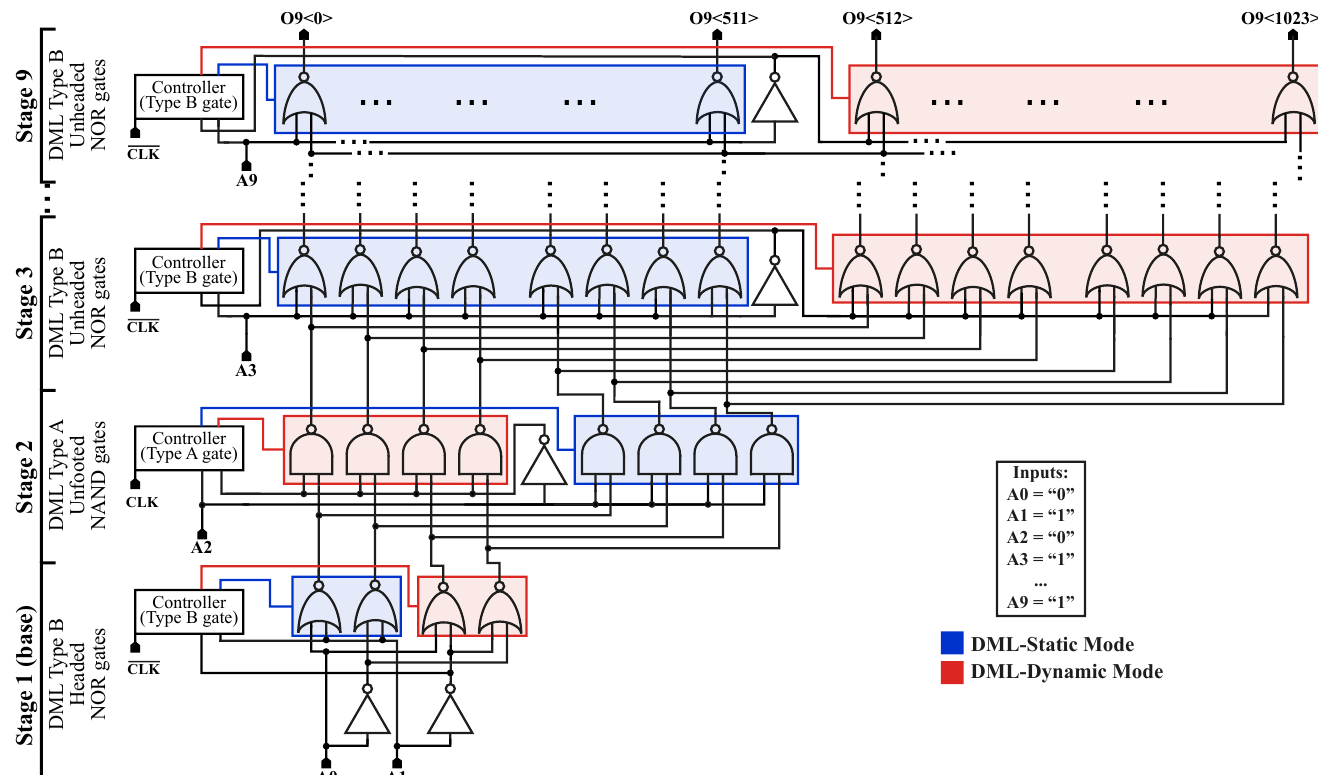
Figure 3. The 1024-bit Self-Adaptive DML Address Decoder